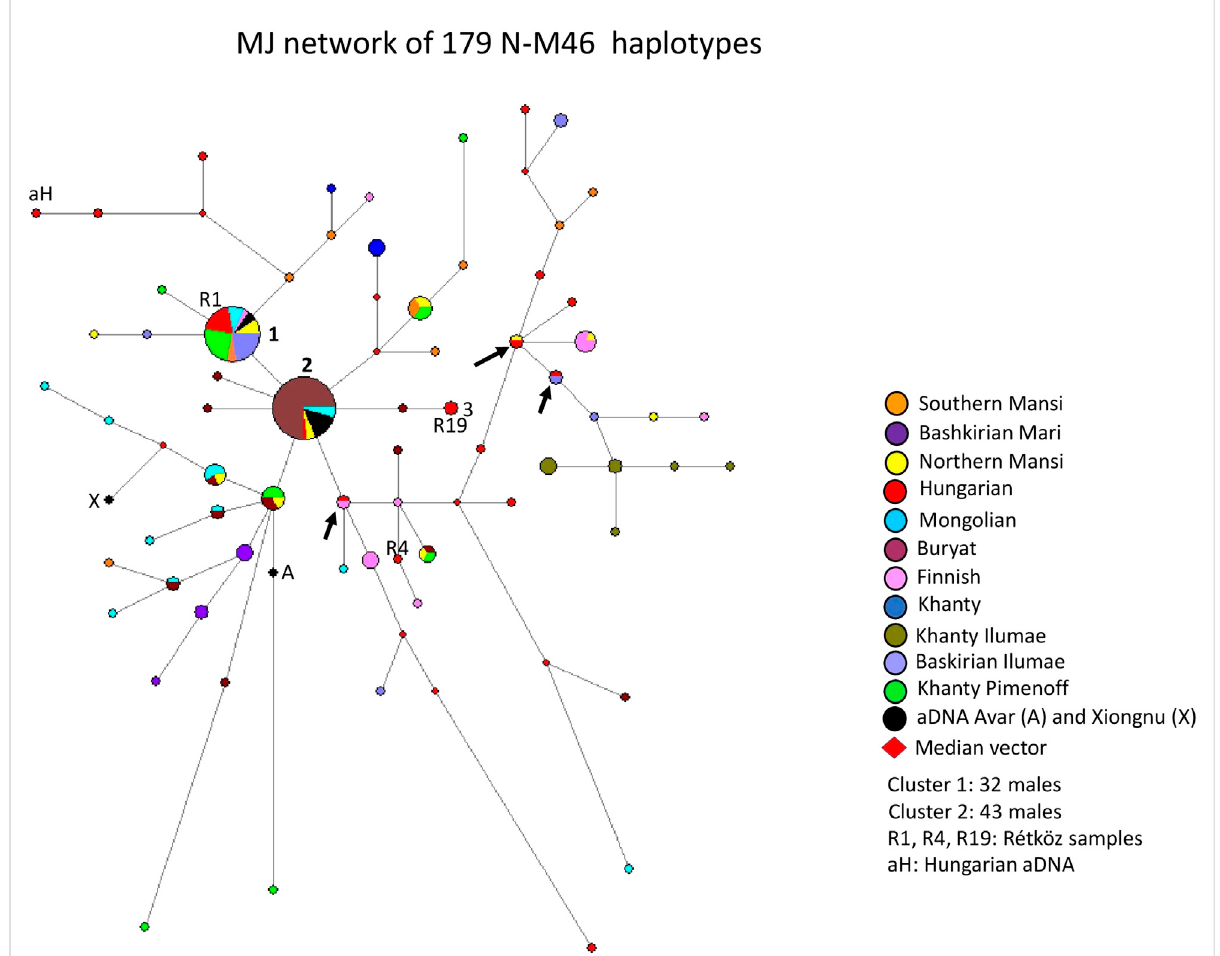
FIGURE 3 The Median-Joining Networks (MJ) of 179 N-M46 haplotypes. The circle sizes are proportional to the haplotype frequencies. The smallest area is equivalent to one